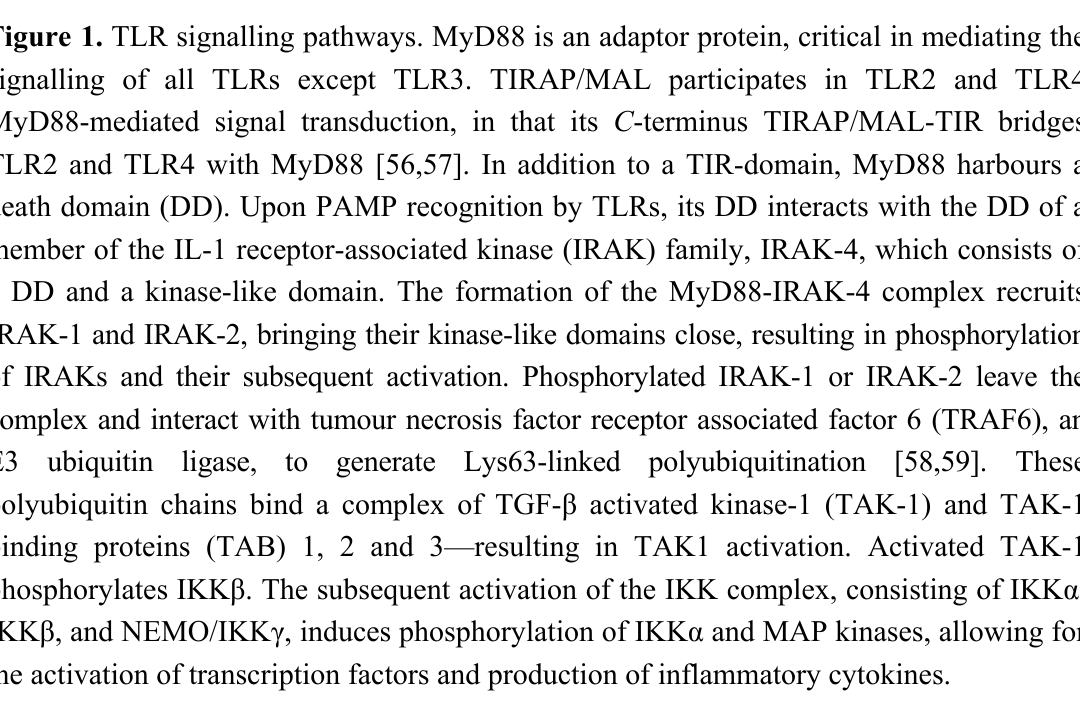
Figure 1. TLR signalling pathways. MyD88 is an adaptor protein, critical in mediating the signalling of all TLRs except TLR3. TIRAP/MAL participates in TLR2 and TLR4 MyD88-mediated signal transduction, in that its C -terminus TIRAP/MAL-TIR